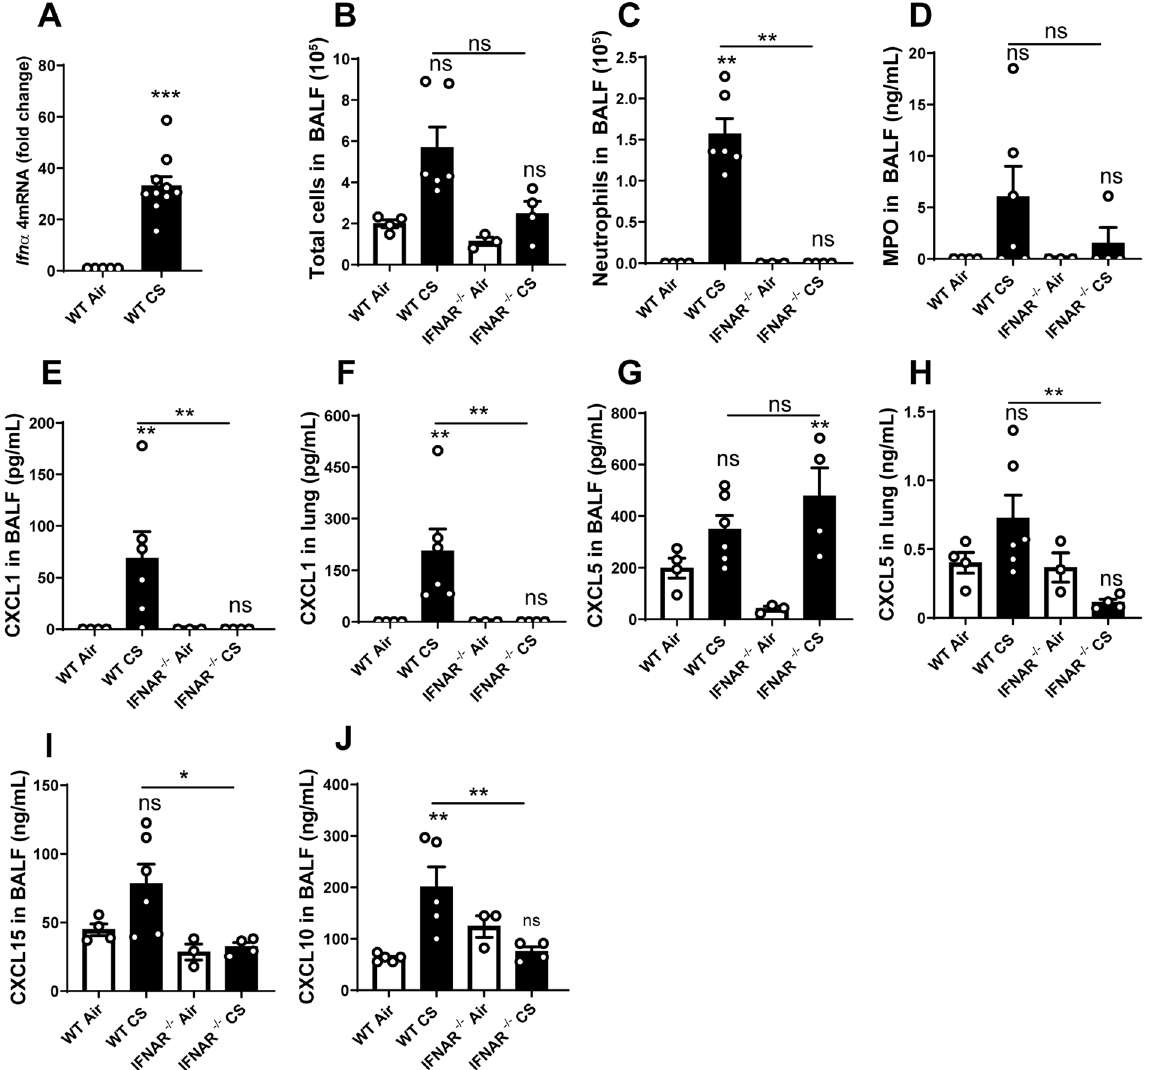
Figure 5. Type I interferon response is involved in CS-induced lung inflammation. Ifn α 4 mRNA expression ( A ) in lung of Air or CS-exposed mice, total cells ( B ), neutrophils ( C ) and MPO level ( D) in BALF after CS- exposure are shown in IFNAR − / − mice. CXCL1 ( E , F ) and CXCL5 ( G , H ) chemokines were measured in BALF and lung. CXCL15 ( I ) and CXCL10 ( J ) measured in BALF are shown. Bar graph are expressed ±